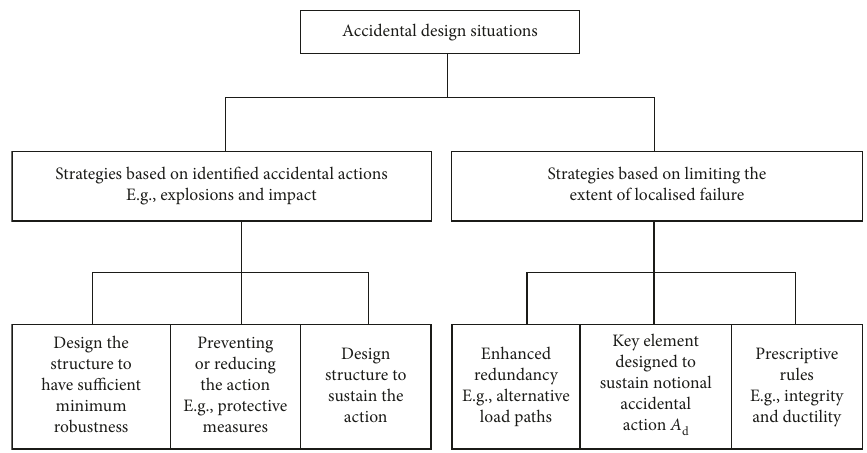
Figure 8: Strategies for accidental design situations according to EN1991-1-7